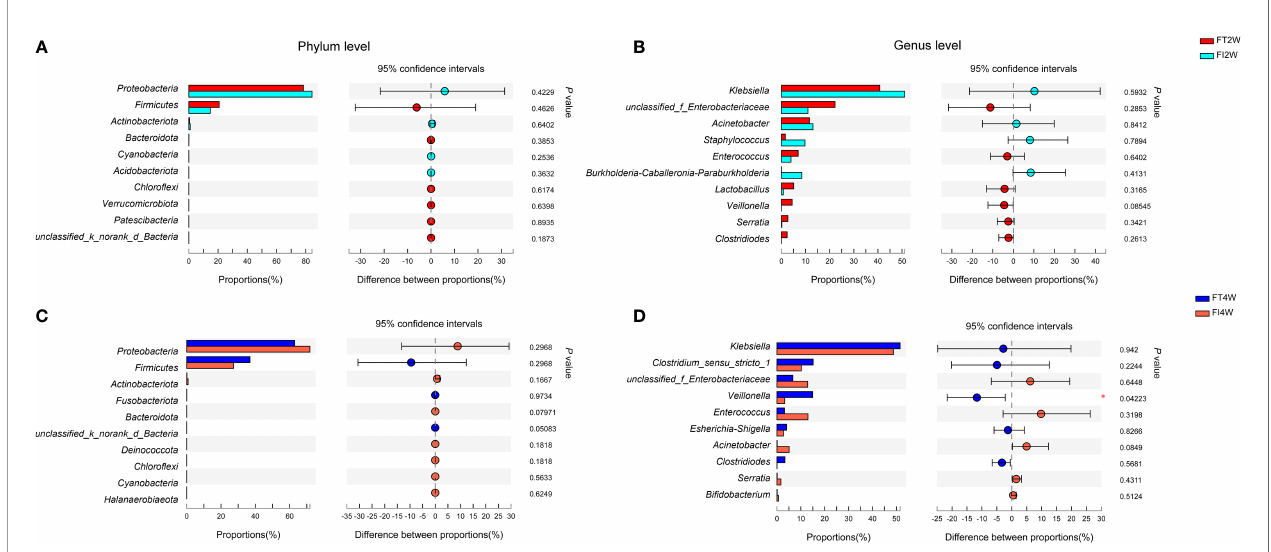
FIGURE 3 | Community abundance in the FI and FT groups. There were no differences between the two groups at the phylum level (A) or genus level (B) at 2 weeks of life. There were no differences between the two groups at the phylum level at 4 weeks after birth (C) . The abundance of Veillonella at the genus level was much lower in the FI group than in the FT group at 4 weeks of life (D) .